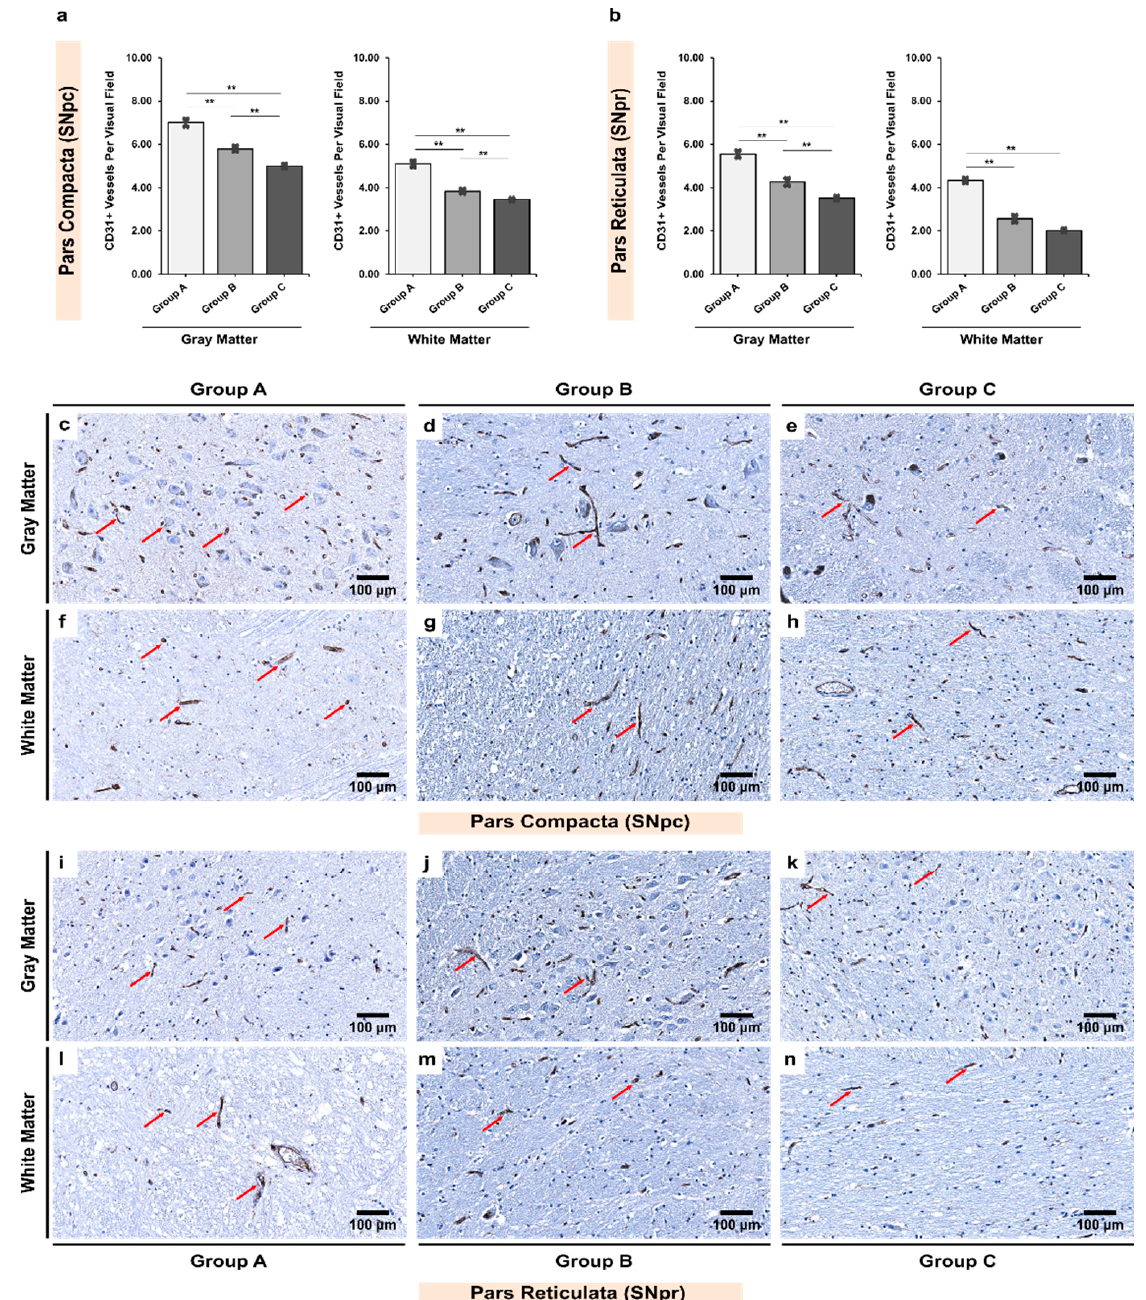
Figure 2. Inter-group analysis of CD31+ vessels per visual field in the ( a ) Pars Compacta (SNpc) and ( b ) Pars Reticulata (SNpr) for the three studied groups in both gray and white matter. The bar plots indicate the average number of CD31+ vessels ± S.E. (Standard Error) seen per visual field; ** indicates a significant difference between the groups ( p < 0.05 with Bonferroni correction is considered as significant). Distribution of CD31+ vessels per visual field in ( c , f , i , l ) group A (controls), ( d , g , j , m ) group B (age-matched alcoholics), and ( e , h , k , n ) group C (non-age-matched alcoholics). Red arrows indicate CD31+ vessels. Original magnification, 200 × . Scale bars, 100 µ